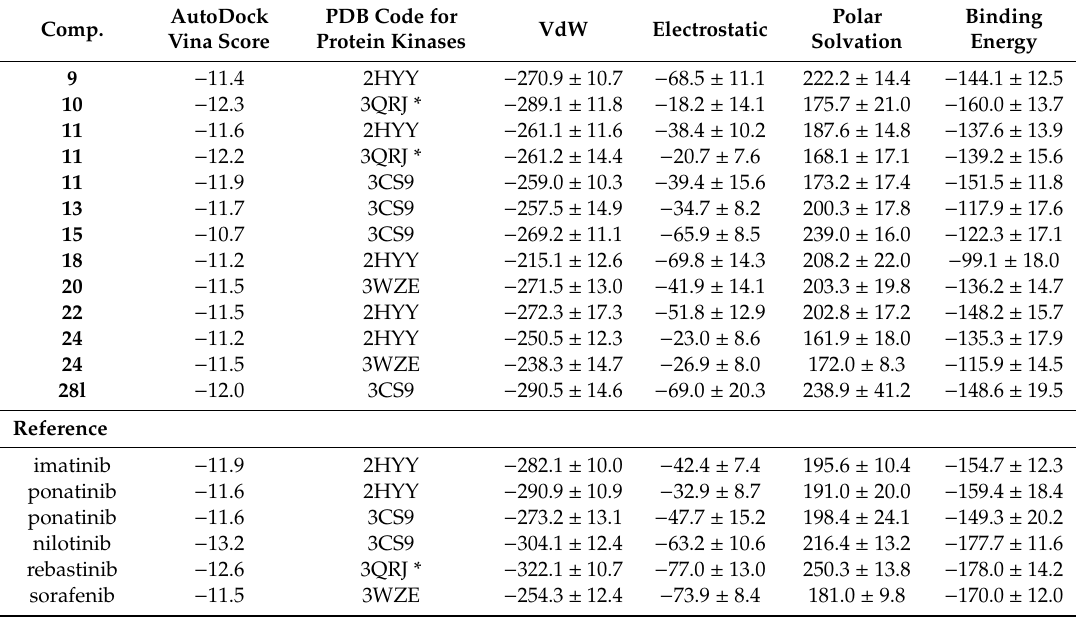
Table 5. Calculated binding a ffi nities for complexes of target structures with protein kinases and reference